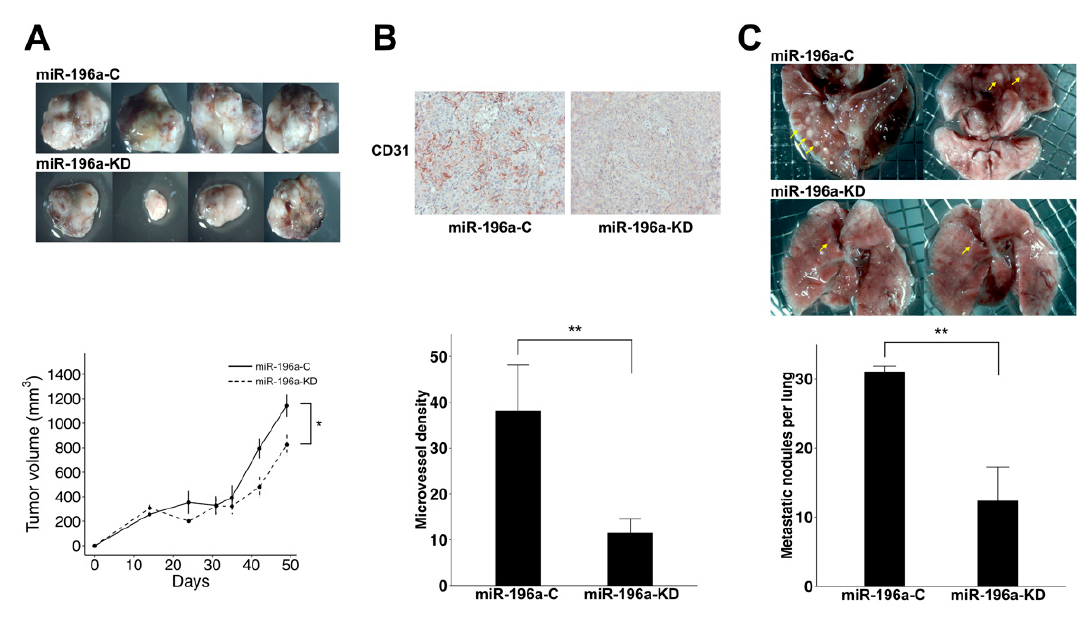
(Mean: 12.3/lungs vs. 31.0/lungs, p = 0.01, Figure 3C). The results indicated that decreased expression of miR-196a led to the suppression of pulmonary metastasis.